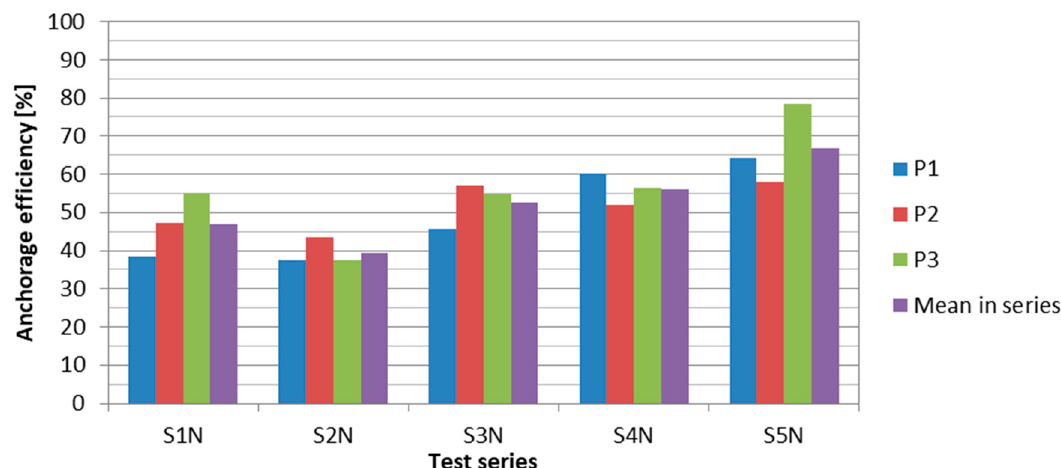
ffi ciency in the subsequent test Figure 25. Anchorage efficiency in the subsequent test series. Figure 25. Anchorage e